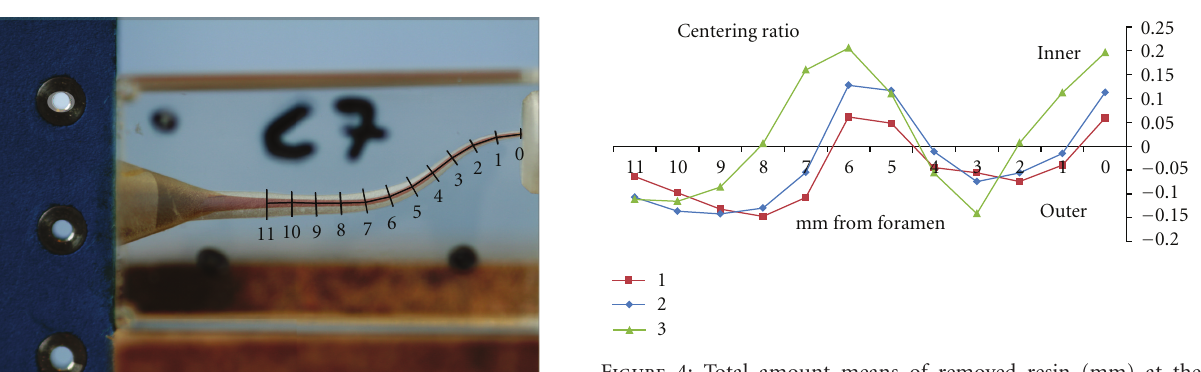
Figure 4: Total amount means of removed resin (mm) at the di ff erent levels after root canal preparation.